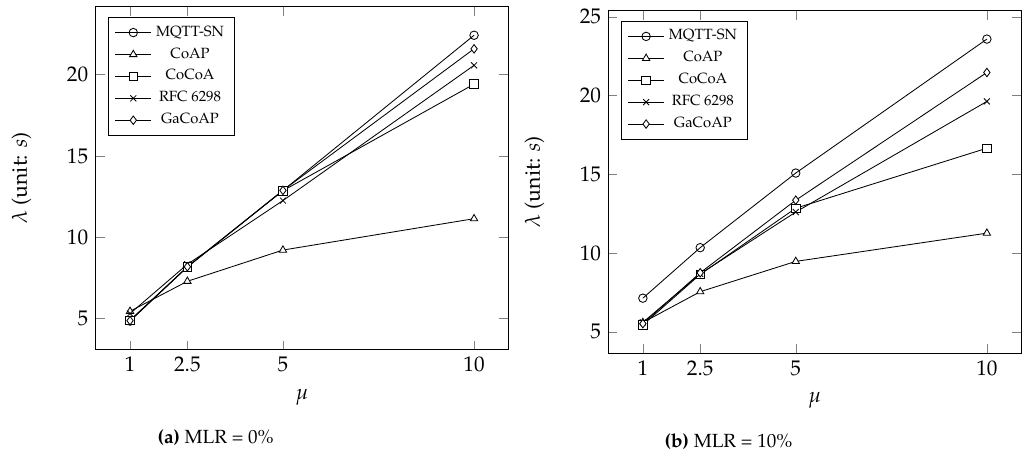
Figure 7. The average latency λ under different µ .